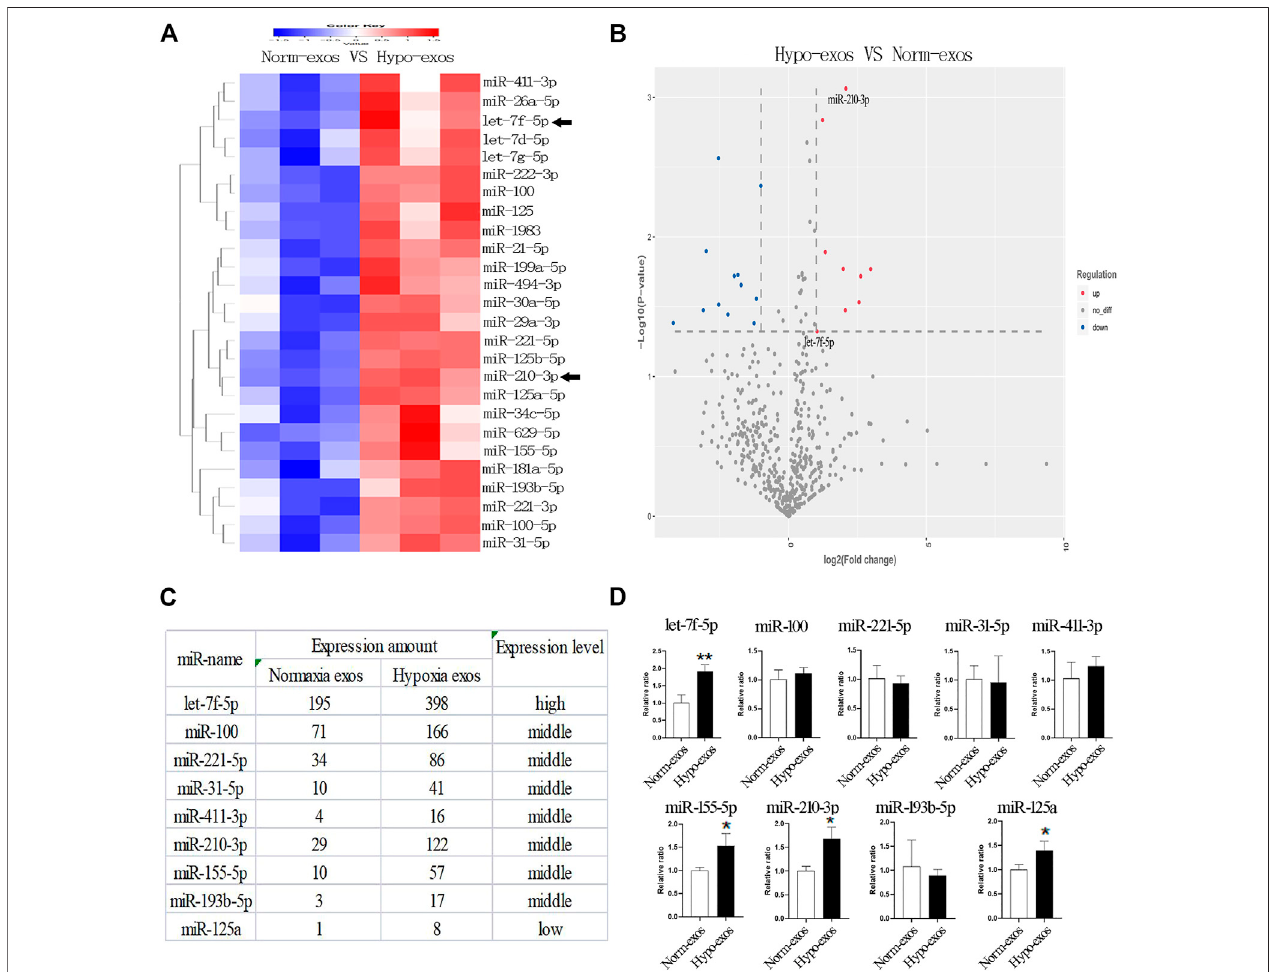
FIGURE5| Pro fi lingandidenti fi cationofupregulatedmiRNAsinHypo-exosandinNorm-exos. (A) Heatmapshowingthepro fi lesofupregulatedmiRNAsinHypo- exoscomparedwithNorm-exos. (B) Volcanomaprevealingninesigni fi cantlyupregulatedmiRNAswitha ≥ 2folddifferencebetweenHypo-exosandNorm-exos. (C) The ninesigni fi cantlyupregulatedmiRNAs( ≥ 2fold, p < 0.05)arelisted. (D) Comparisonoflet-7f-5p,miR-100,miR-221-5p,miR-31-5p,miR-411-3p,miR-210-3p,miR-155- 5p, miR-193b-5p and miR-125a between Norm-exos and Hypo-exos by qRT-PCR. * p < 0.05, ** p < 0.01.